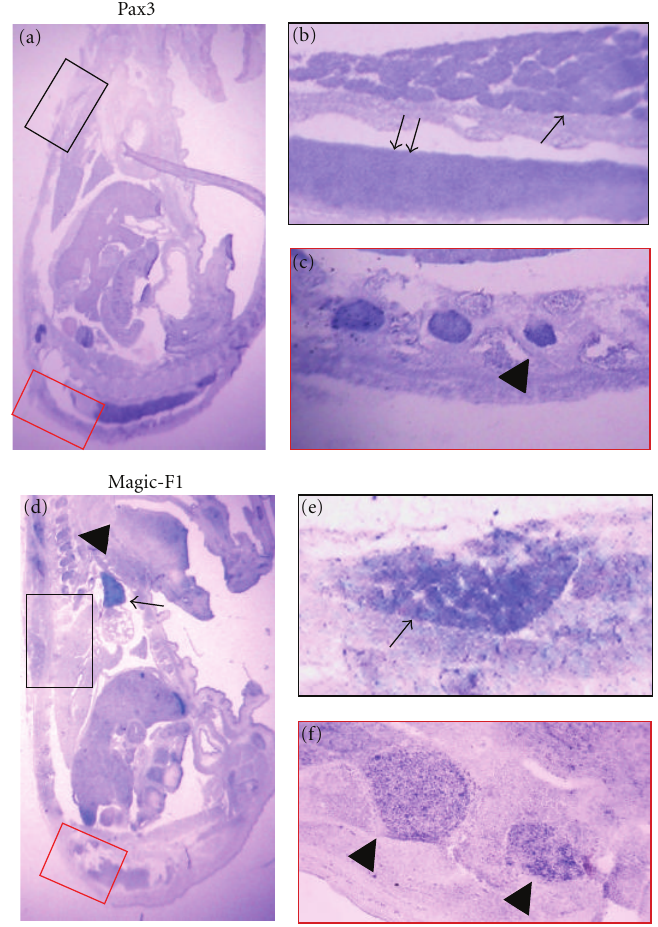
Figure 5: Expression of Pax3 and Magic-F1 at 15.5 dpc. Sagittal section of 15.5dpc mouse hybridized with digoxigenin-labeled antisense Pax3 riboprobes (a); specific Pax3 transcripts are localized in cartilage primordium of tail vertebral body, cutaneous muscles (arrow) of thorax and trunk regions and in mid-cervical region of spinal cord (double arrow) as shown in (b); expression was also localized in cartilage primordium (arrowhead) of dorsal part of shaft region (c); (d) sagittal section of 15.5 dpc mouse hybridized with Magic-F1 cRNA probes and signal is observed in cartilage primordium of anterior arch of cervical vertebra (arrowheads) and right lobe of thymus gland (arrow); specific Magic-F1 transcripts are also localized in cutaneous muscles (arrow) of thorax and trunk regions (e); (f) higher magnification cartilage primordium of dorsal part of shaft region of